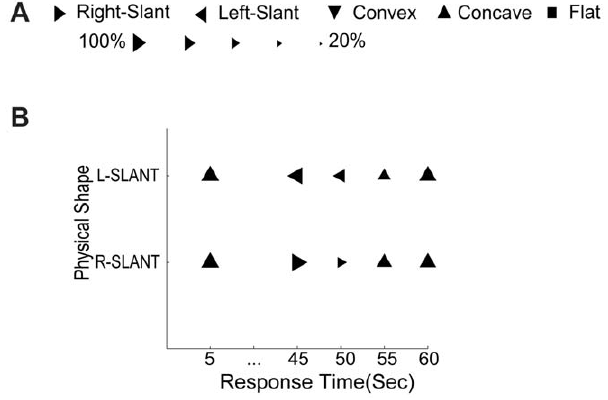
Figure 4. Results of Experiment 2. (A) Symbols: Most frequently reported shape (5 trials 6 3 observers). Size: Proportion of majority responses per condition. (B) Data panel shows majority shape reported when viewing L-slant and R-slant sinusoidal corrugations covered by random-dot texture with haptic feedback consistent with simulated 3-D shape. Observers viewed the stimulus for 5 sec without haptic- feedback, reported the shape, then touched the stimulus for 40 sec, reported the shape, and then made reports every 5 secs without any additional haptic feedback.